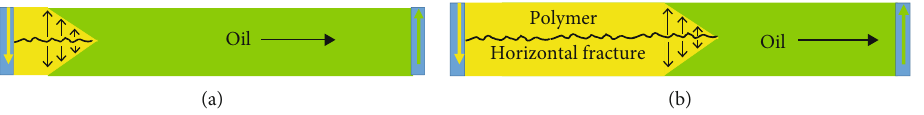
Figure 5: Illustration of propagation of a horizontal fracture during polymer